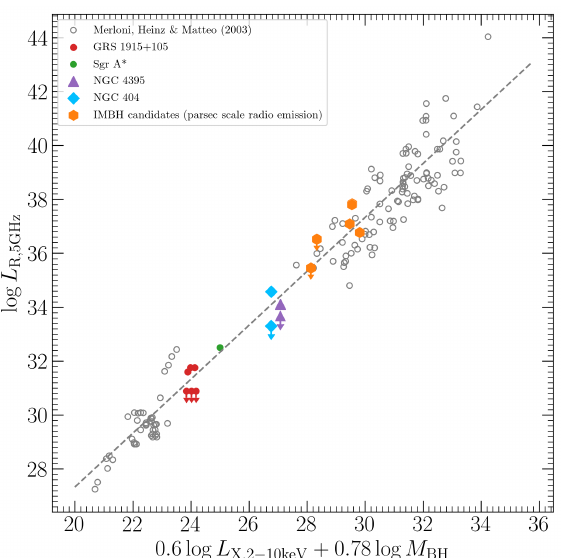
Figure 1. The fundamental plane relation of black hole activity with the parsec scale radio luminosity of IMBH candidates. The XRBs, data for Sgr A ∗ and GRS 1915 + 105 and AGNs are from Merloni et al. [39] and the IMBH candidates are from Yang et al. [46] and Yang et al.